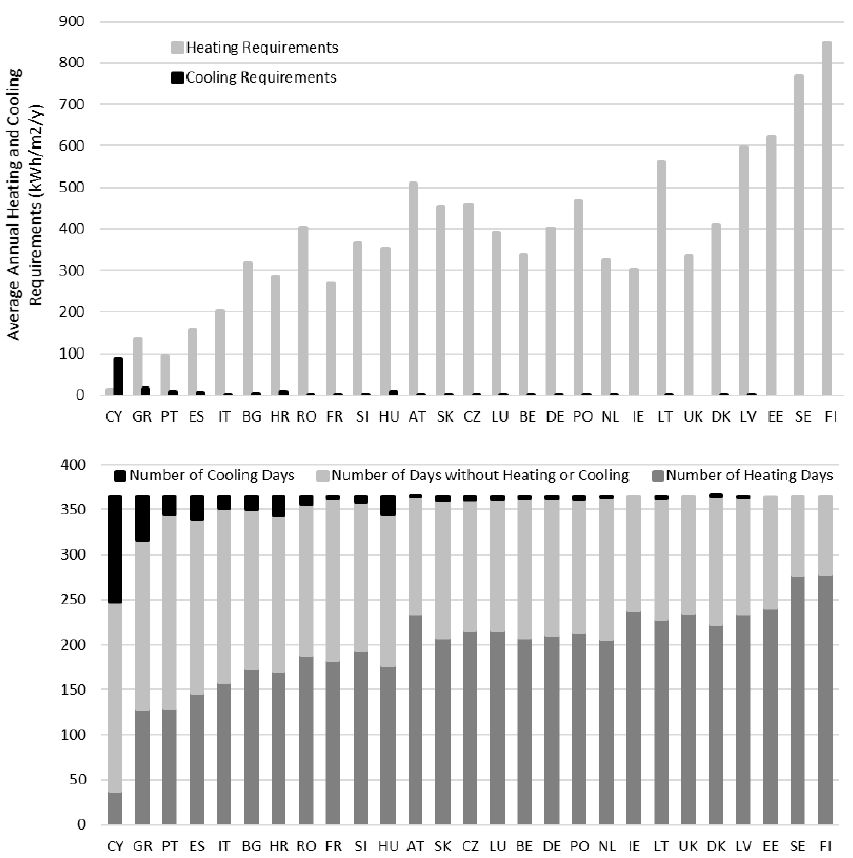
Figure 4. Summarized results of all EU countries. Annual heating and cooling requirements and number of days with heating, cooling, and no energy requirements. Average values for the 2008–2018 period. Table 2. Comparative representation of the annual energy greenhouse needs in the present study vs Garc í a et al. [35]. Heating Needs in This Work Heating Needs in Garc í a et al. Country (kWh / m 2 / y) (kWh / m 2 /